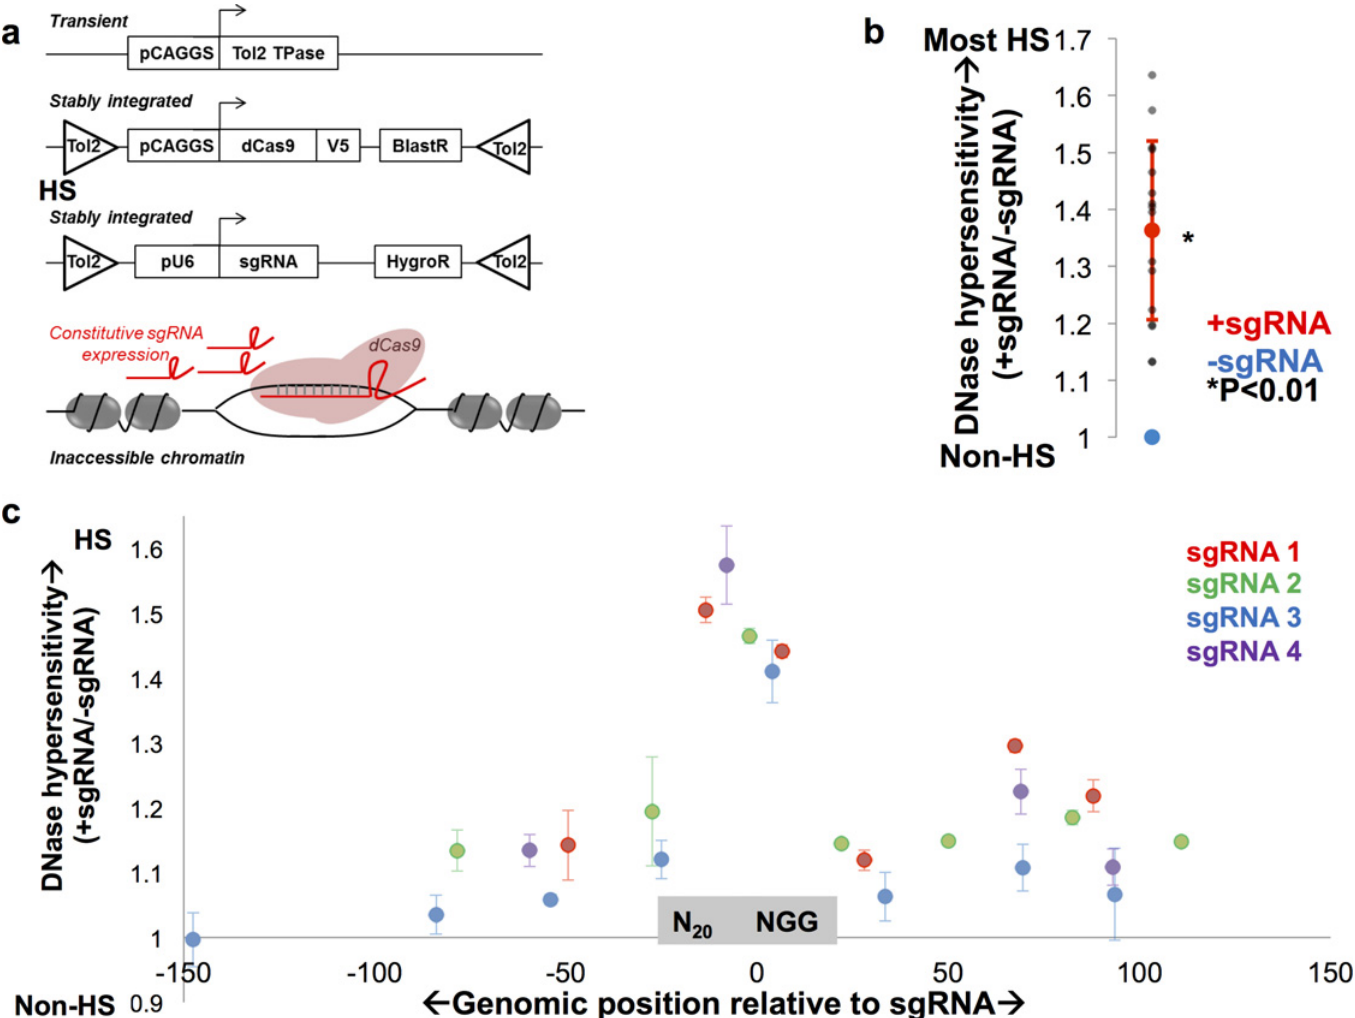
Fig 1. dCas9 induces chromatin accessibility at previously inaccessible genomic loci. a . mESCs were co-transfected with a Tol2 transposase (TPase), a Tol2 transposon-flanked dCas9 expression cassette, and a Tol2 transposon-flanked sgRNA cassette to yield stable expression of dCas9 and a sgRNA targeted to a region with inaccessible chromatin. b . 16/16 loci in previously inaccessible chromatin had statistically significant increases in DNase hypersensitivity (y-axis) upon sgRNA targeting as measured by DNase-qPCR (gray dots). DNase hypersensitivity at each locus is normalized to its level in the absence of sgRNA (blue dot), and the average normalized DNase hypersensitivity in the presence of gRNA for all loci is shown (red dot), which is statistically significantly increased over – sgRNA control. At least two replicates were performed for all conditions, and a two-tailed Student ’ s t-test used to calculate significance. c . DNase-qPCR measurement of DNase hypersensitivity (y-axis) is shown +/-150 bp from the sgRNA site (x-axis) at four targeted loci. DNase-qPCR values at each datapoint are normalized to hypersensitivity in the absence of sgRNA, and all loci are oriented such that the 20 bp sgRNA sequence is immediately to the left of 0 and the NGG PAM sequence is immediately to the right of 0. Three replicates were performed for all